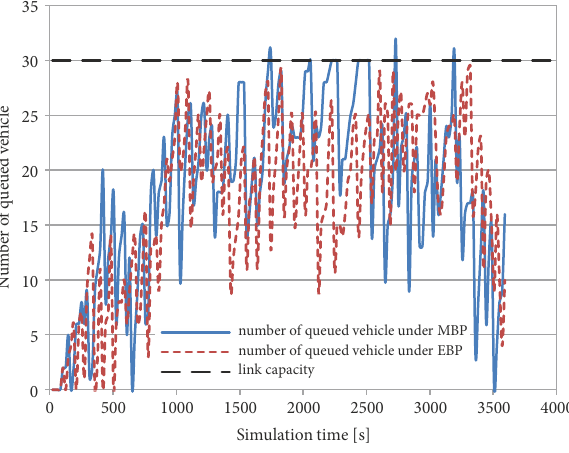
Figure 7. Number of queued vehicle on a link under EBP and MBP Table 2. Performance indexes of traffic network during simulation in Vissim Average number of